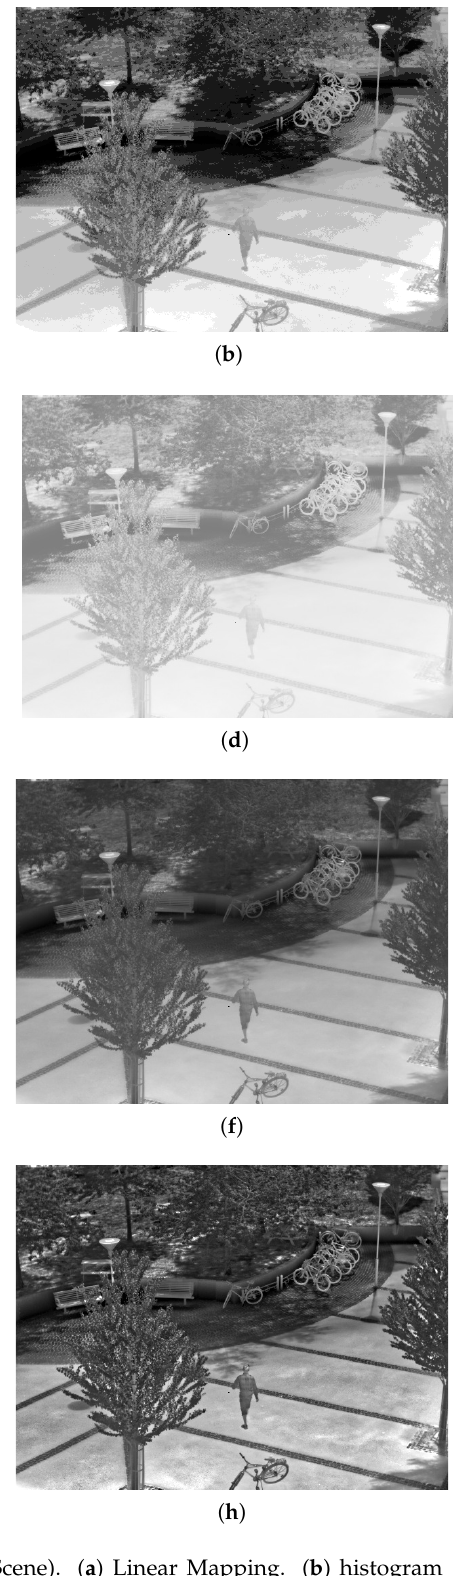
Figure 4. Comparison results 1 (Image of Complex Scene). ( a ) Linear Mapping. ( b ) histogram equalization (HE). ( c ) contrast-limited adaptive histogram equalization (CLAHE). ( d ) AHPBC. ( e ) MSR. ( f ) Reinhard. ( g ) LEP. ( h ) Proposed